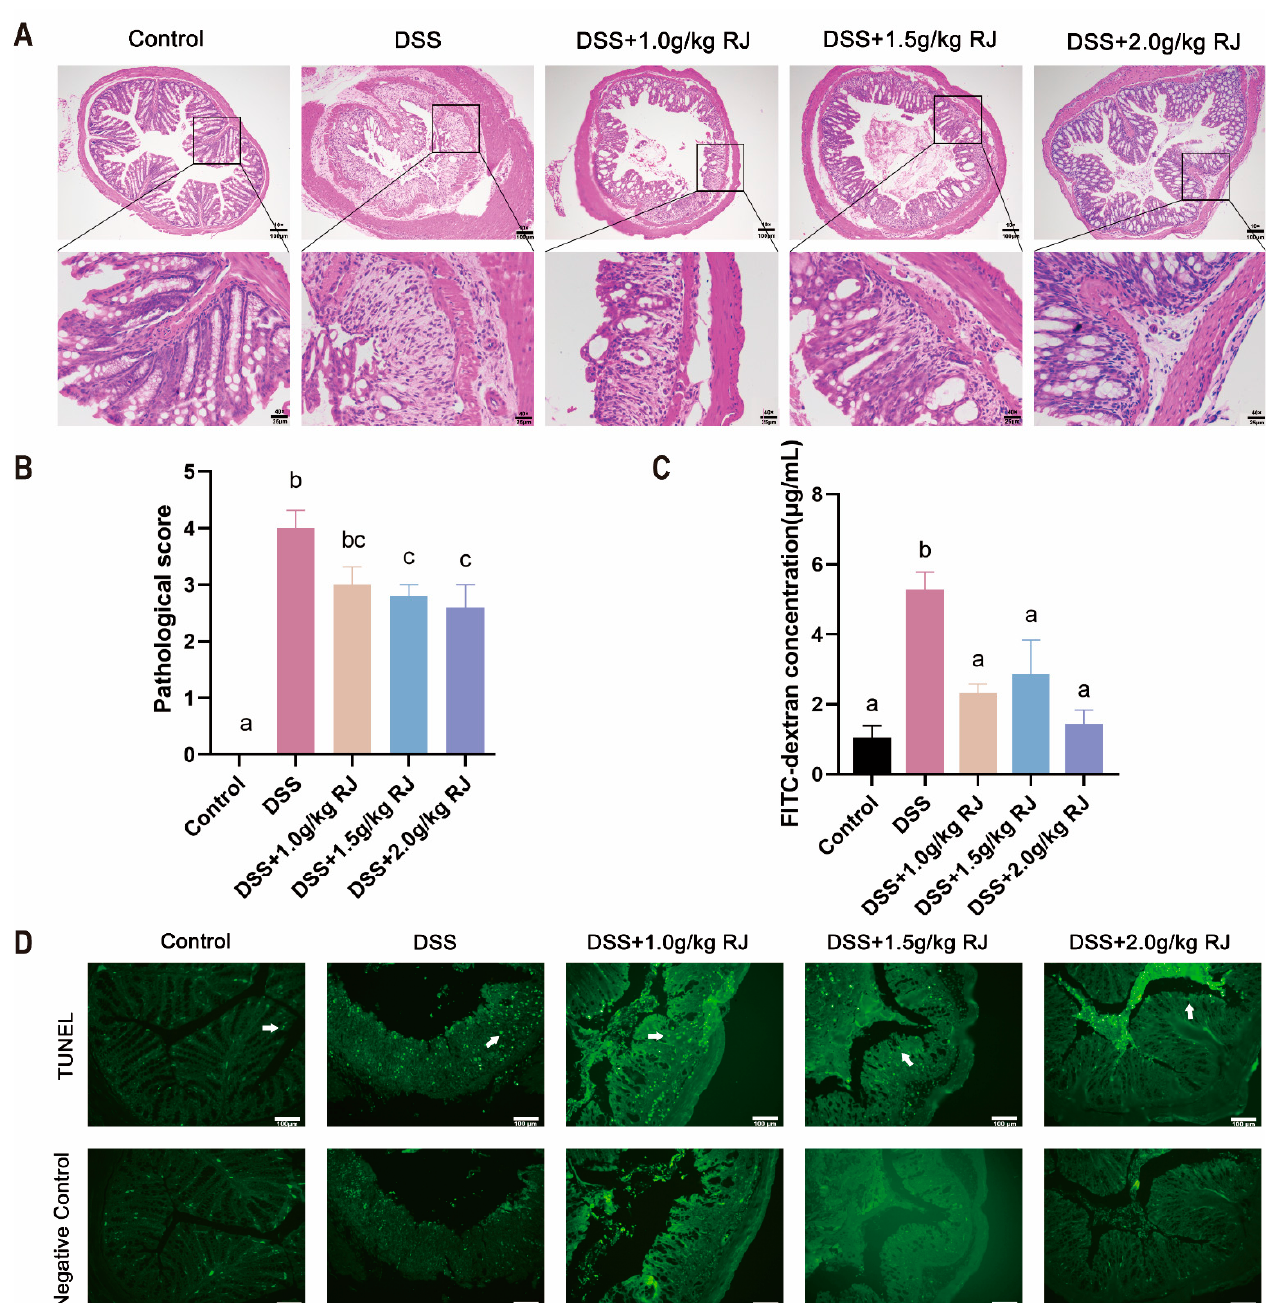
Figure 2. Oral administration of royal jelly improved the colon damage induced by DSS in mice with ulcerative colitis. ( A ) HE staining of colon tissue. The first line of the scale bar is 100 μ m, and the second line of the scale bar is 25 μ m. ( B ) Histopathological score of colon ( n = 5). ( C ) Changes in intestinal permeability ( n = 4). ( D ) TUNEL staining ( n = 3). The white arrow points to apoptotic cells. The scale bar is 100 μ m. Data are expressed as mean ± standard error (SEM). The groups marked with different letters had significant differences.